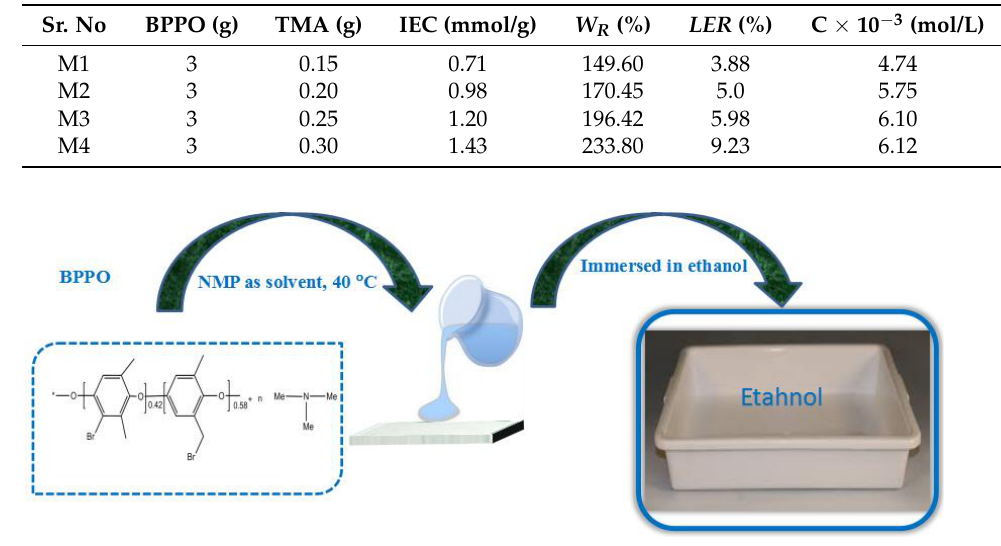
Figure 5. Illustration of phase-inversion method for the fabrication of anion exchange membrane.